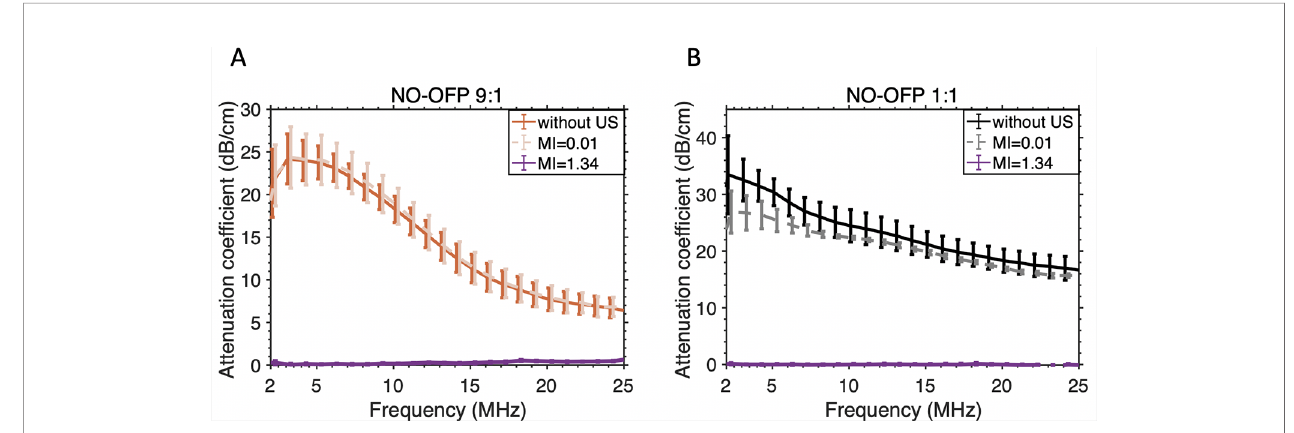
FIGURE 8 | Attenuation-coef fi cient of NO-OFP-MB [ (A) 9:1 v/v, (B) 1:1v/v] without ultrasound or after exposure to ultrasound at MI=0.01 (used for imaging) or MI=1.34 (ultrasound-triggered gas payload release). The mean ± 1 standard deviation is depicted (n = 3). NO-OFP-MB, Nitric oxide and octa fl uoropropane microbubbles.